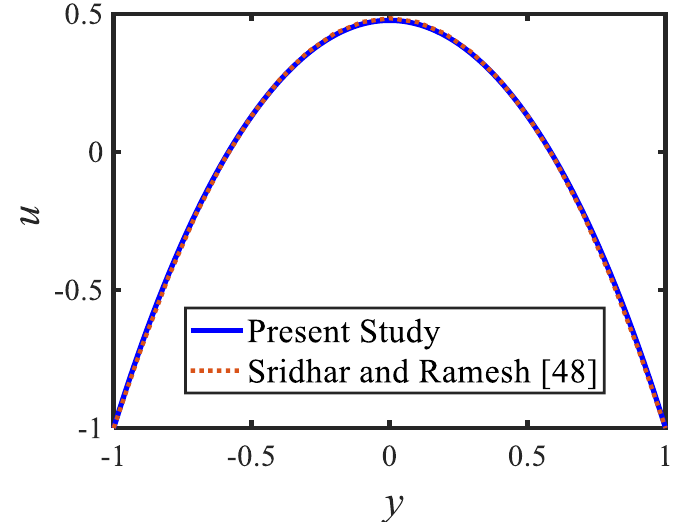
Figure 8. Comparison of the velocity profiles of the present study and [51].